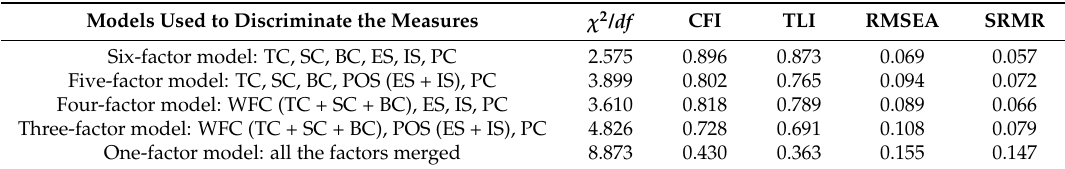
Table 4. The comparative results of alternative